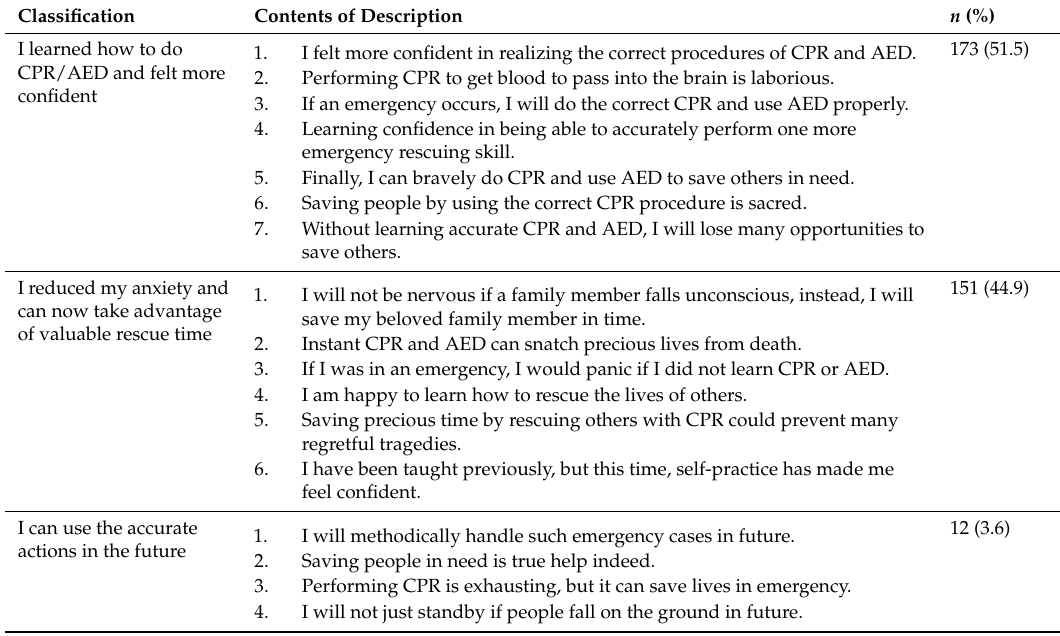
Table 3. Lessons learned from the short education session and self-practice of